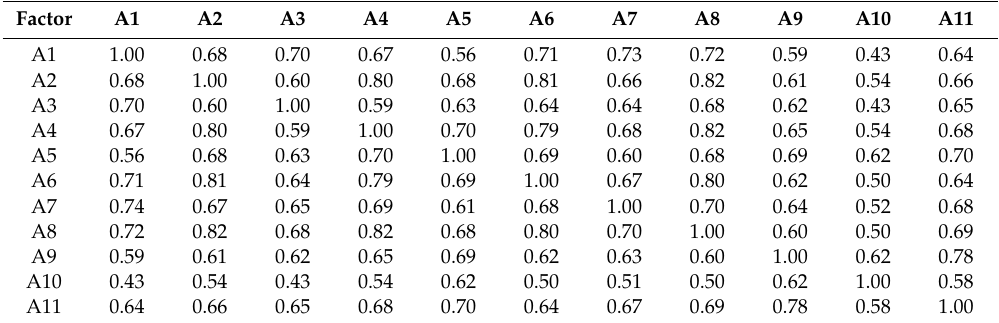
The grey relational degree of load and the gas concentration was between 0.43 and 0.62, indicating that there was a strong correlation between the load and gas concentration of CH 4 , C 2 H 2 , C 2 H 4 and CO 2 , while the correlation between load and H 2, C 2 H 6 was weak. (2) The grey relational degree between oil temperature and each gas concentration was between 0.58 and 0.69, which indicates that oil temperature had strong correlation with each gas concentration. (3) The grey relational degree of ambient temperature and gas concentration was between 0.64 and 0.70, indicating that there was also a strong correlation between ambient temperature and gas